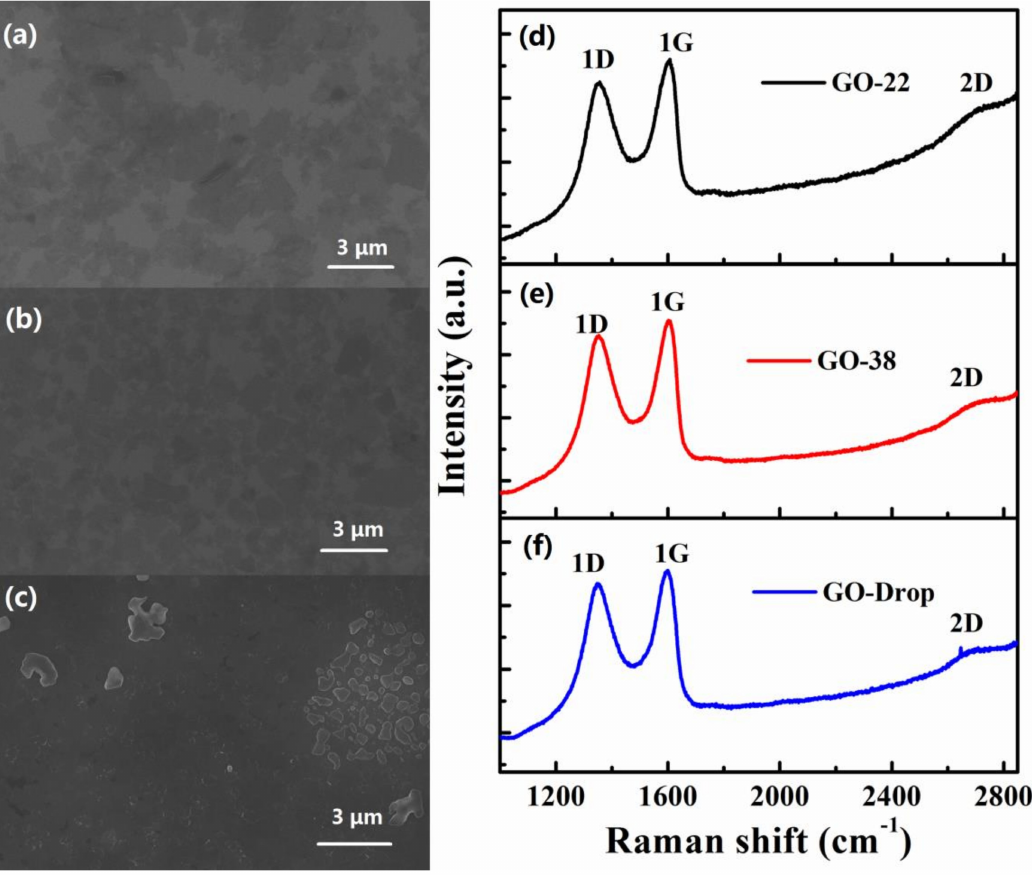
Figure 4. SEM image of GO SA samples prepared by the LB method (samples GO-22 ( a ) and GO-38 ( b )) and by the drip method (sample GO-Drop ( c )). Raman spectra of the GO-22 ( d ), GO-38 ( e ) and GO-Drop ( f )